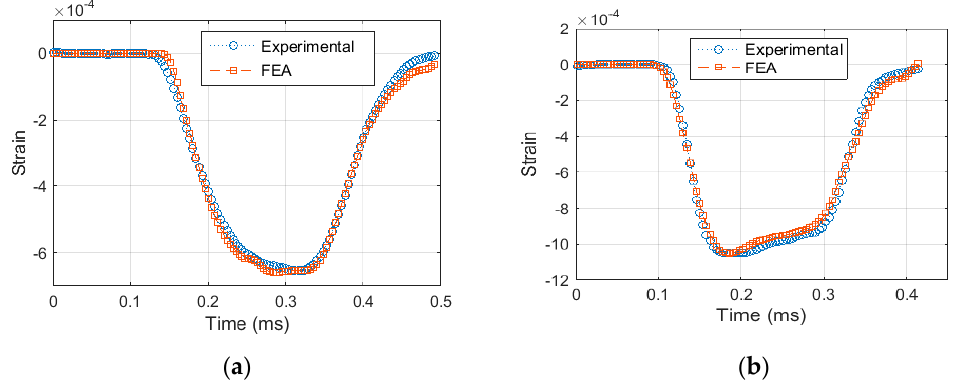
Figure 9. Experimental and FEM results for the incident pulse generated by a copper pulse shaper under different impact velocities. ( a ) 6.6 m/s ( b ) 11.0 m/s.